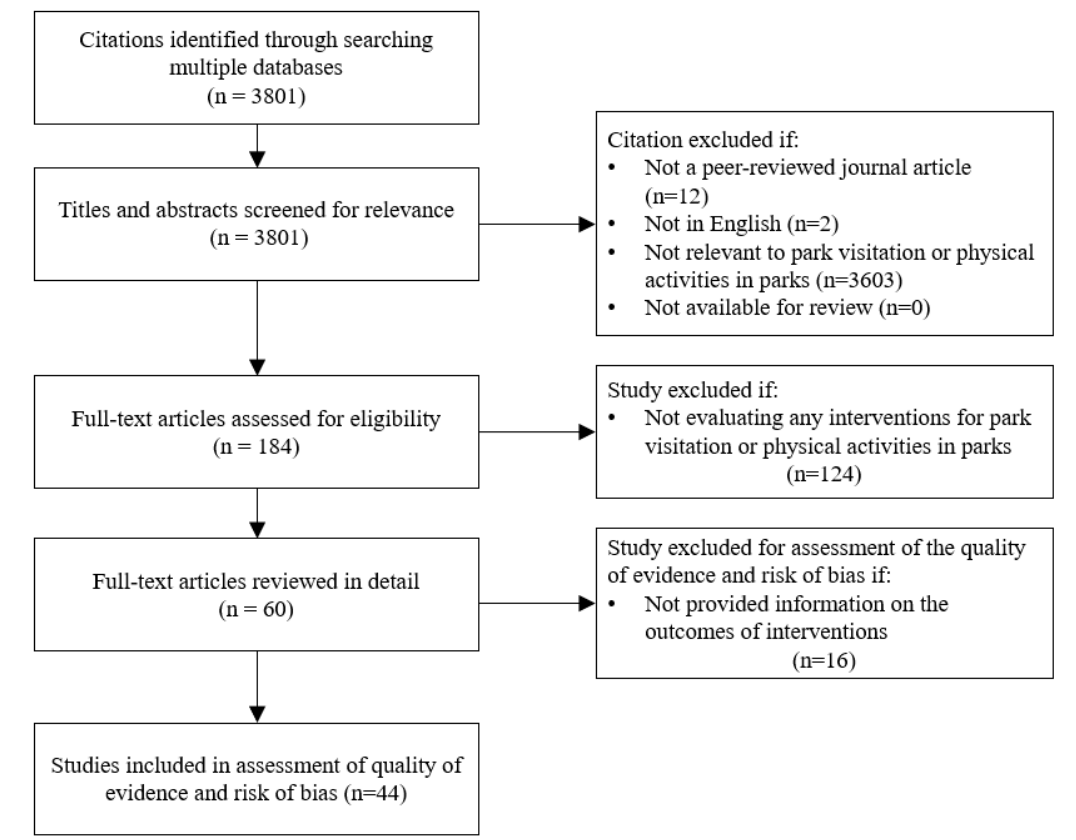
Figure 1. PRISMA flowchart of the literature selection process. Source: Authors’ own design.